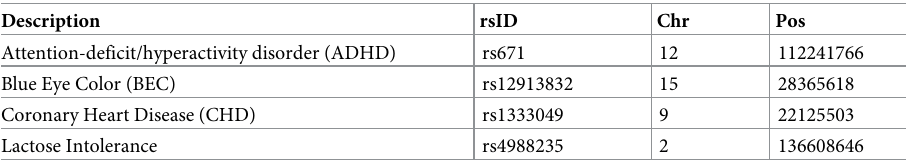
Table 1. Variants used for testing Stat